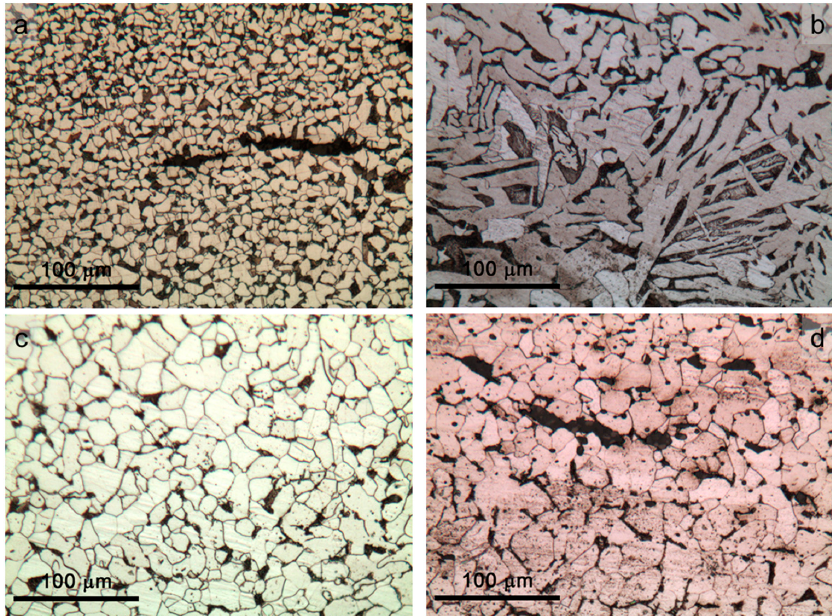
Figure 5. Microstructure observed by optical microscopy in the cross-sections of the iron samples from the San Carlone and on the reference sample of puddled iron after etching with Nital2. Outermost areas of the samples: ( a ) Sample 44—slightly corroded sample in contact with copper; ( b ) Sample 46—slightly corroded sample not in contact with copper; ( c ) Sample 87—heavily corroded sample in contact with copper; and ( d ) Sample A—reference sample of puddled iron.